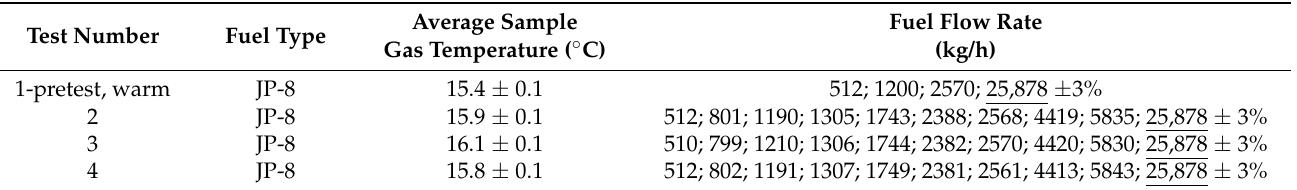
Table 2. Engine test